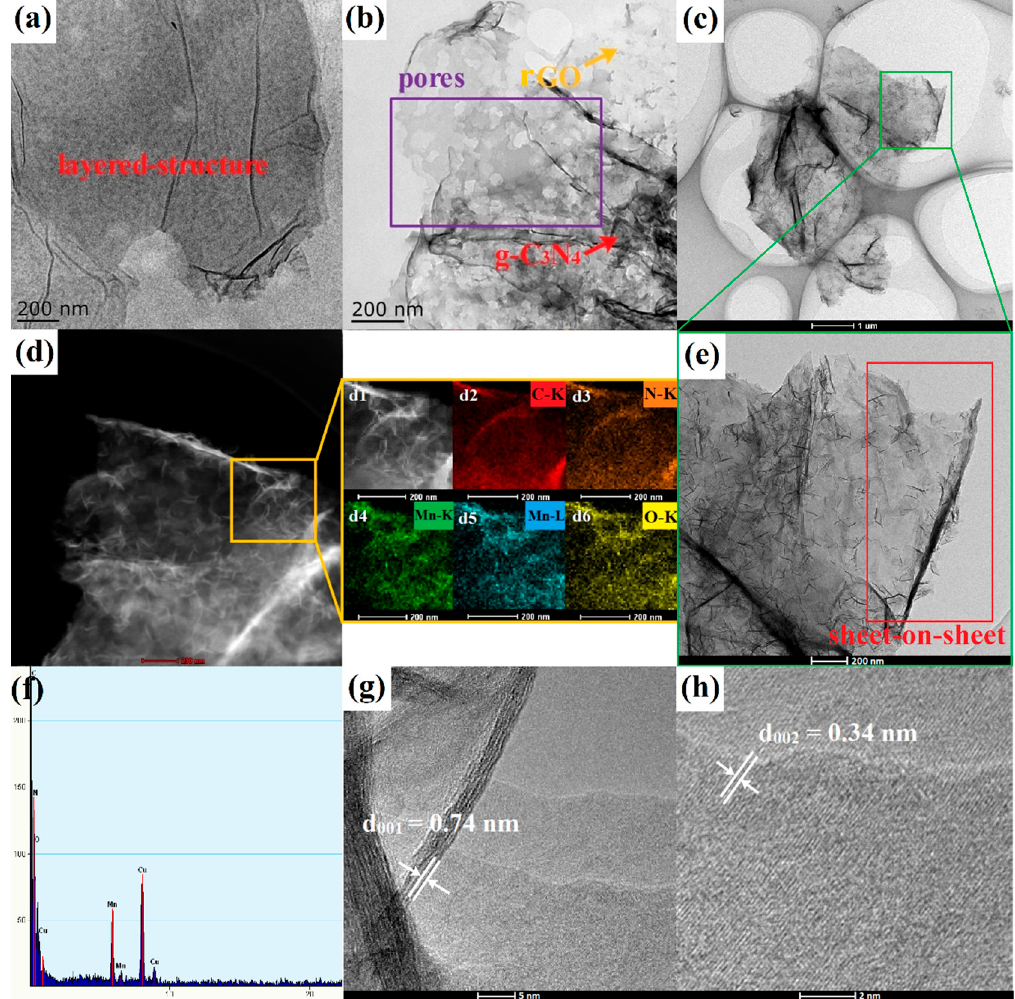
Figure 6. TEM images of ( a ) GO, ( b ) g-C 3 N 4 /rGO and ( c , e ) g-C 3 N 4 /rGO/MnO 2 ternary nanocomposite. ( d ) elemental mappings, ( f ) EDS spectrum, ( g , h ) HRTEM images of the g-C 3 N 4 /rGO/MnO 2 ternary nanocomposite. (inset images, corresponding height).